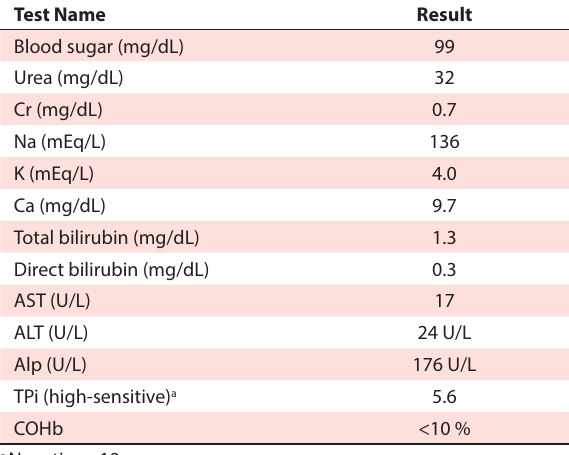
Table 2. Laboratory data: blood test results at